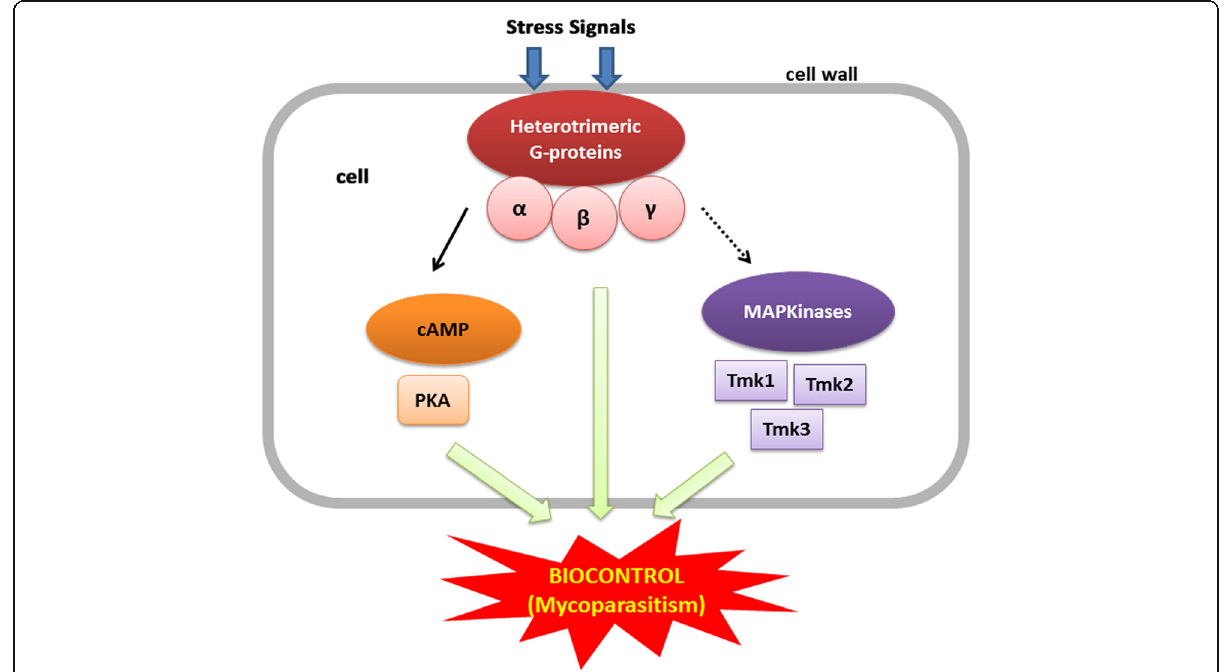
Fig. 3 Schematic representation of signalling pathways involved in